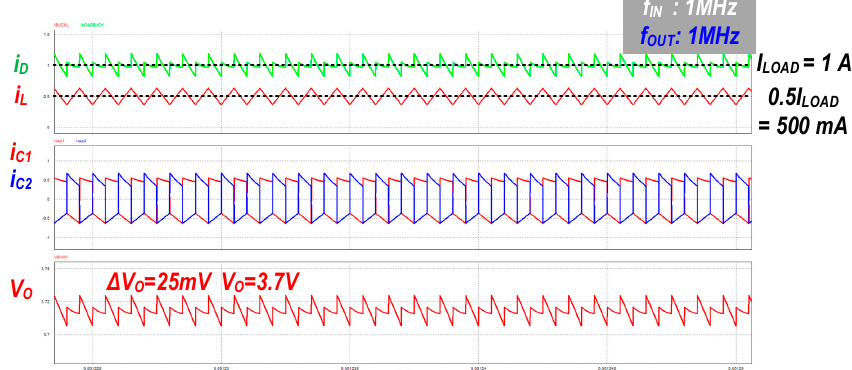
Figure 20. Simulated waveforms of the multi-phase buck converter with energy transfer media (MBKETM) with f IN = 1 MHz and f OUT = 1 MHz.